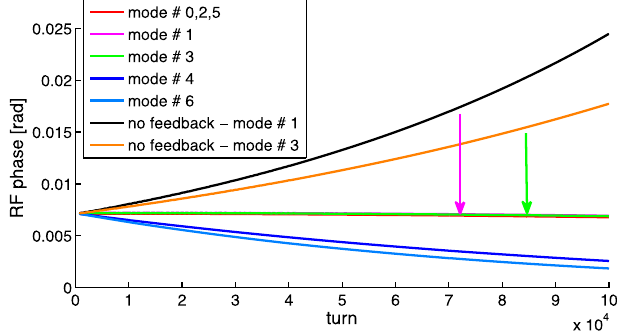
FIG. 6. Amplitude of the multibunch oscillation mode μ ¼ 1 as a function of the number of turns given by M U S I C with R ¼ 6 k Ω , R ¼ 7 k Ω , and R ¼ 8 k Ω . The bunches have a Gaussian distribution with rms bunch length equal to 3% of the rf wavelength.